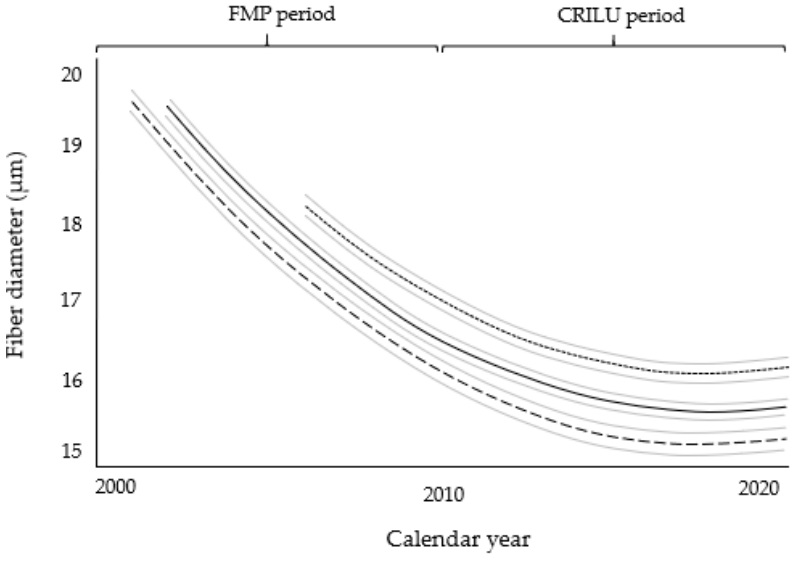
Figure 1. Two-year-old ewes, 3–6-year-old ewes, and ewes aged seven years or older phenotype trends using a second-degree polynomial regression model for the average fiber diameter across calendar years (2001–2020).